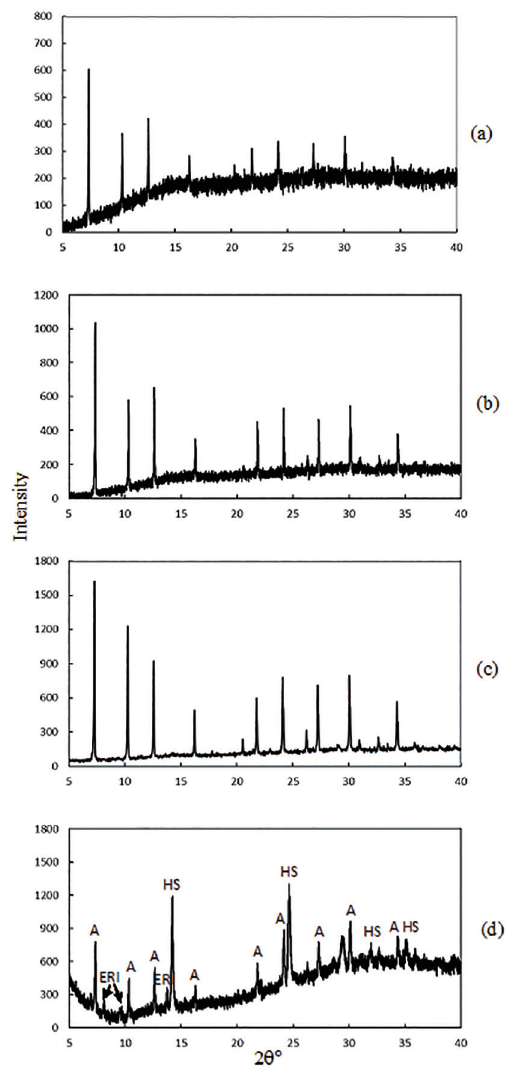
Figure 1. XRD patterns of the coatings prepared from composition C after (a) 3.5 h, (b) 4.5 h, (c) 5.5 h and (d) 18 h of conventional primary synthesis at 90 0 C.